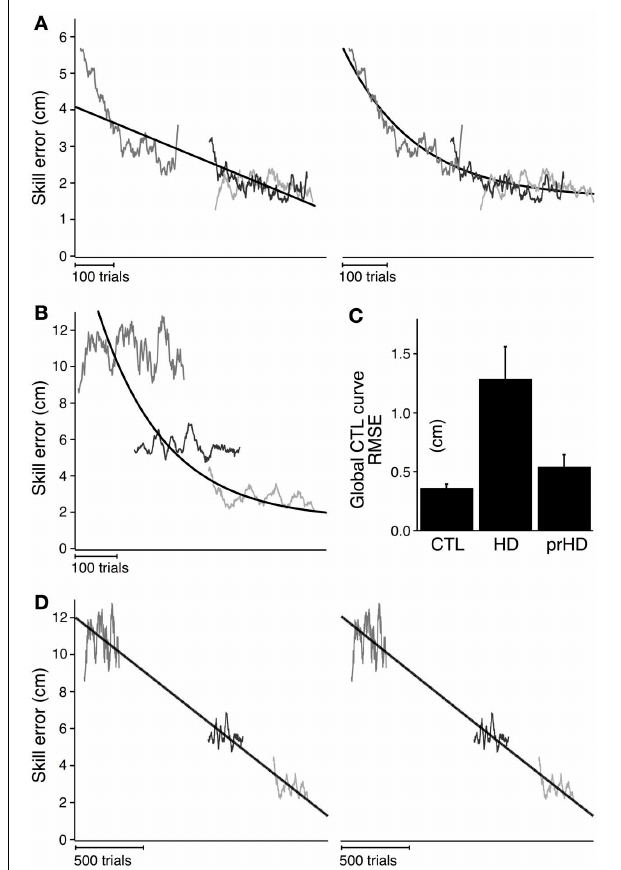
FIGURE 5 | Modeled time course of speed-accuracy learning. (A) Black lines indicate the time course of skill error for the CTL group as modeled linearly (left; slope = − 0 . 004; intercept = 3.19; AIC = 426) and exponentially (right; time constant = 162.4; amplitude = 2.08; AIC = 117). Smoothed skill errors of three sample CTL subjects (gray) are plotted such that RMSE is minimized. Their position along the x -axis is determined by the global fit process, which treats the learning curves for all subjects in a group as having the same learning rate but allows them to start at subject-specific initial error values. (B) Same exponential fit as (A) (black line), but with the smoothed skill errors of three sample HD subjects (gray). (C) Group averages (mean ± SE) of RMSE calculated with respect to the exponential learning curve for CTL. (D) Black lines indicate the time course of skill error for the HD group as modeled linearly (left; slope = − 0 . 006cm/trial; intercept = 5.88cm; AIC = 4051) and exponentially (right; time constant = 62502 trials; amplitude = 364.1cm; AIC = 4052). Smoothed skill errors of three sample HD subjects (gray) are plotted such that RMSE is